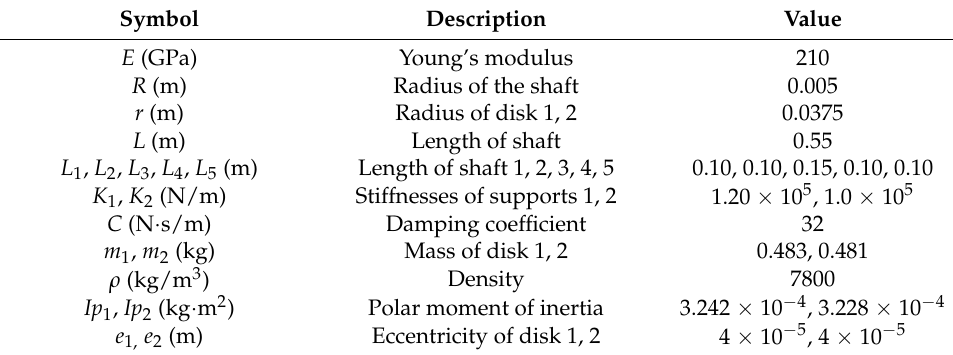
Figure 5. Schematic diagram of the dual-disk rotor model. Table 1. Values of physical parameters of the dual-disk rotor.